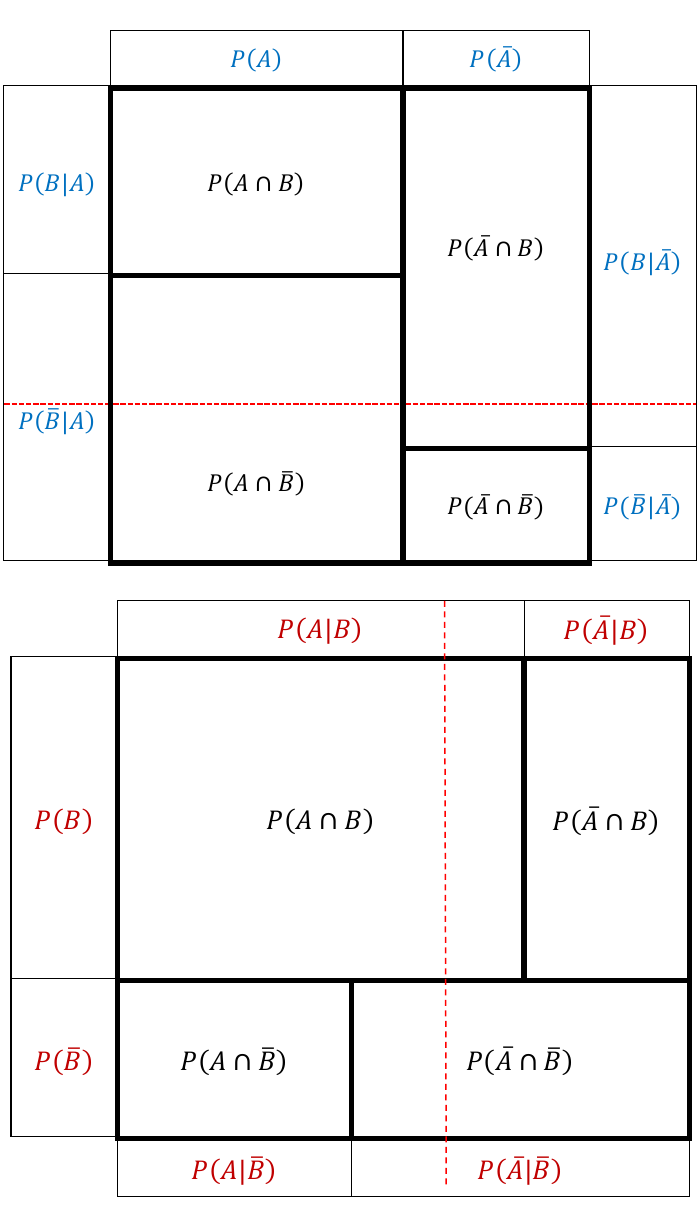
Figure 5. The probability diagrams of Figure 4 redrawn for the case of two mutually disfavoring (weakening) events. (𝑃(𝐴|𝐵) < 𝑃(𝐴)) , (𝑃(𝐵|𝐴) <